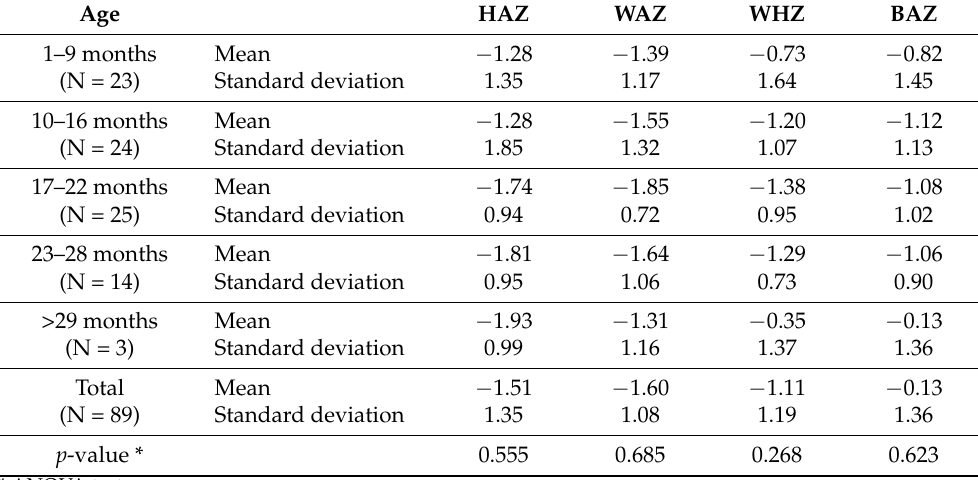
Table 2. Anthropometric values for the studied children from 1 to >29 months.